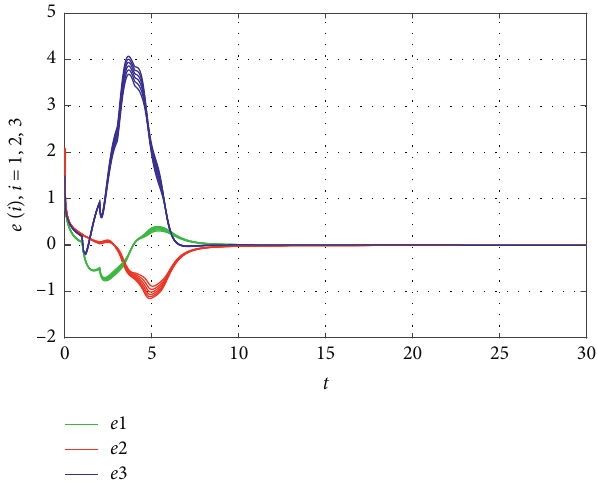
( t ) under the different i